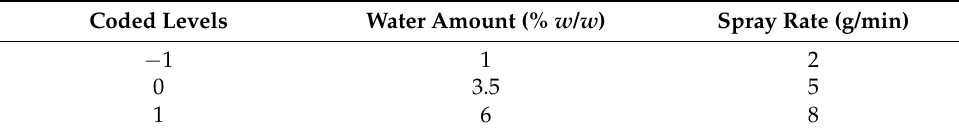
Table 1. Key process variables used in the design of experiments.